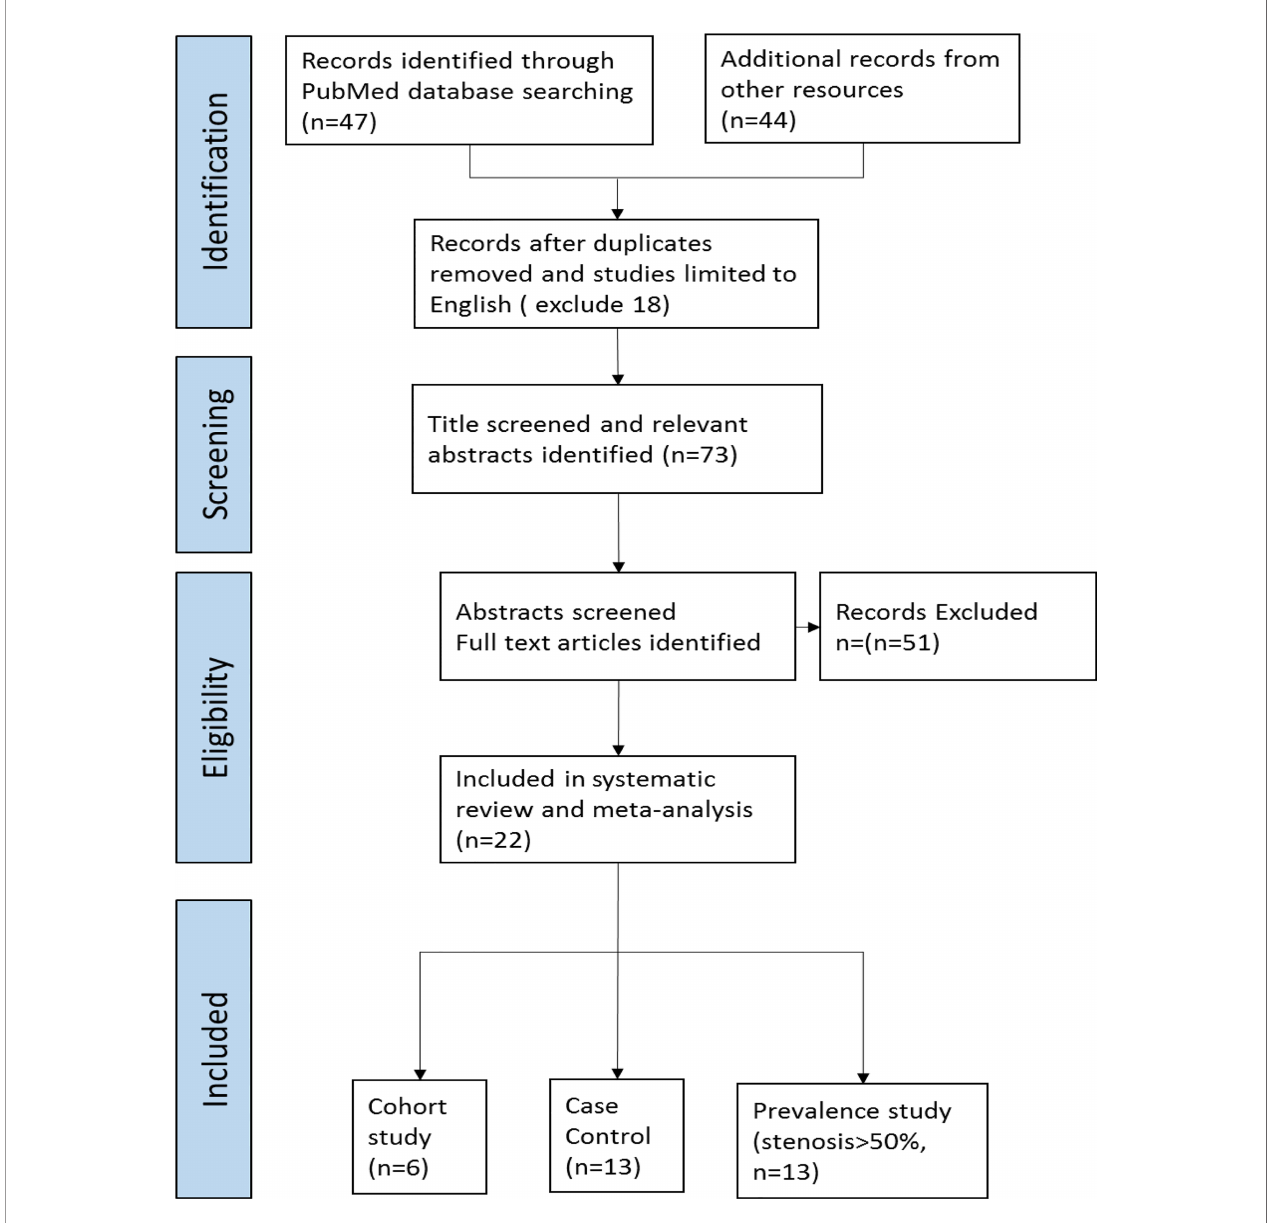
FIGURE 1 | PRISMA fl ow diagram of searching